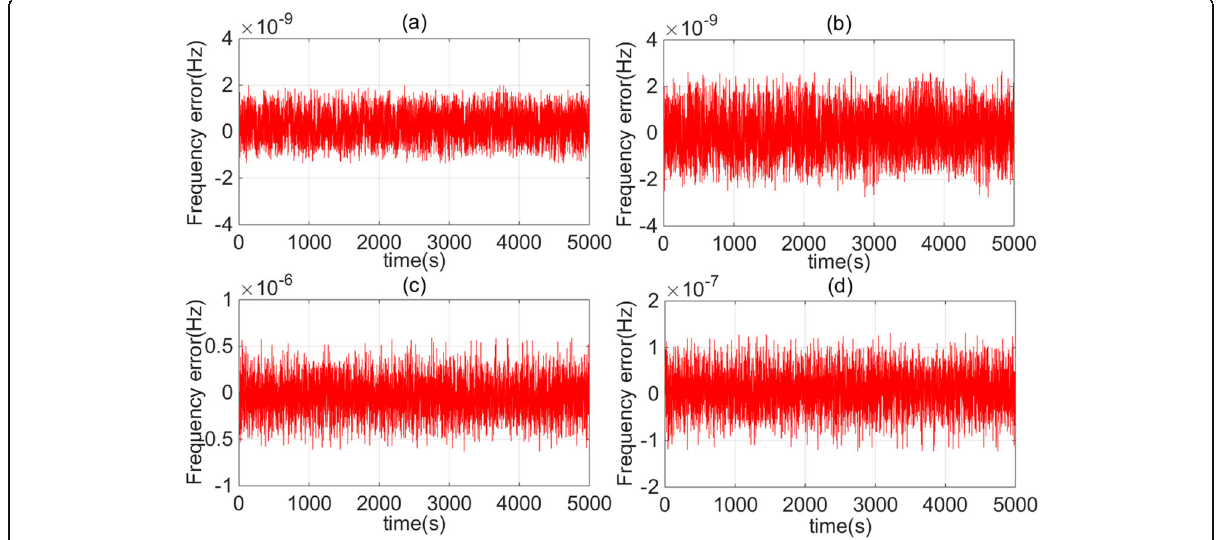
Fig. 8 Frequency transfer error curve under ideal conditions without observation